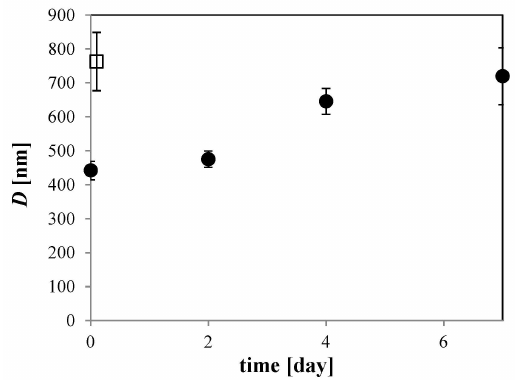
Figure 5. Storage time dependence of D in 100 mM NaCl solution at 293 K (solid circle). Open squares show D in pure water. Error bars are the standard error based on a normal distribution.